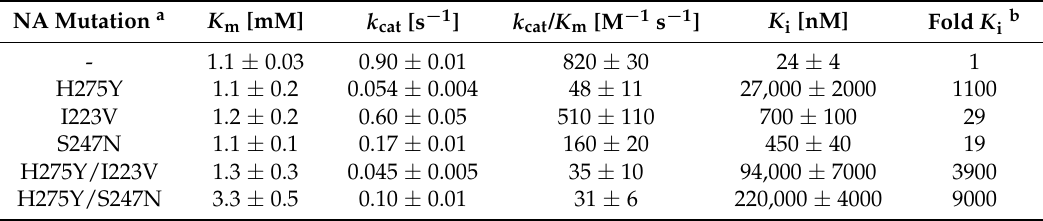
Table 2. Kinetic parameters of recombinant wild-type neuraminidase NA2009 and oseltamivir-resistant mutants calculated as means and s.d. from two independent